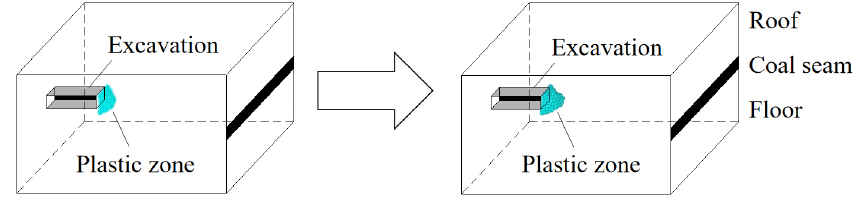
Figure 6. The expansionary evolution of the plastic zone in event I.